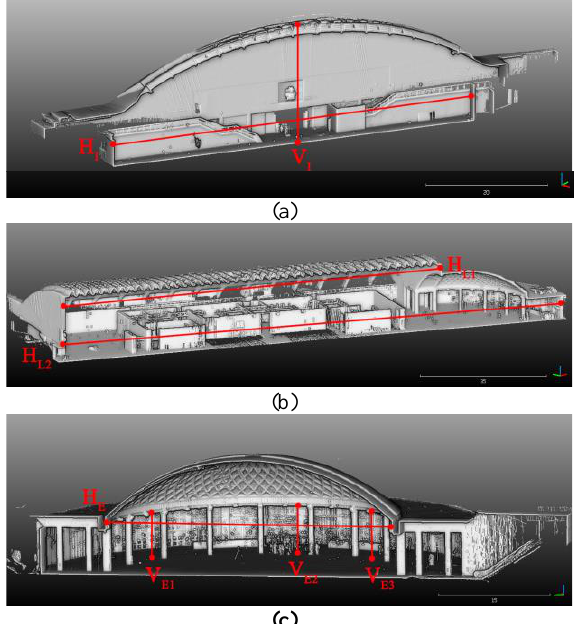
Figure 5 . The indication of the distance measurements